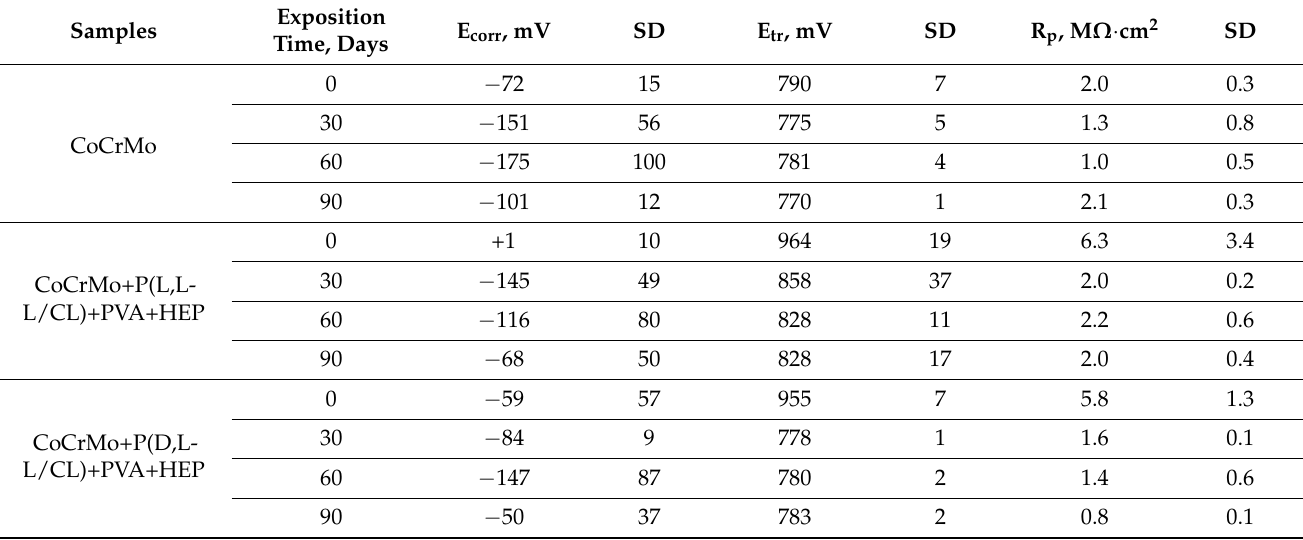
Table 3. Results of potentiodynamic tests of resistance to pitting corrosion of CoCrMo alloy modified with biodegradable heparin-releasing coatings exposed to artificial urine for up to 90